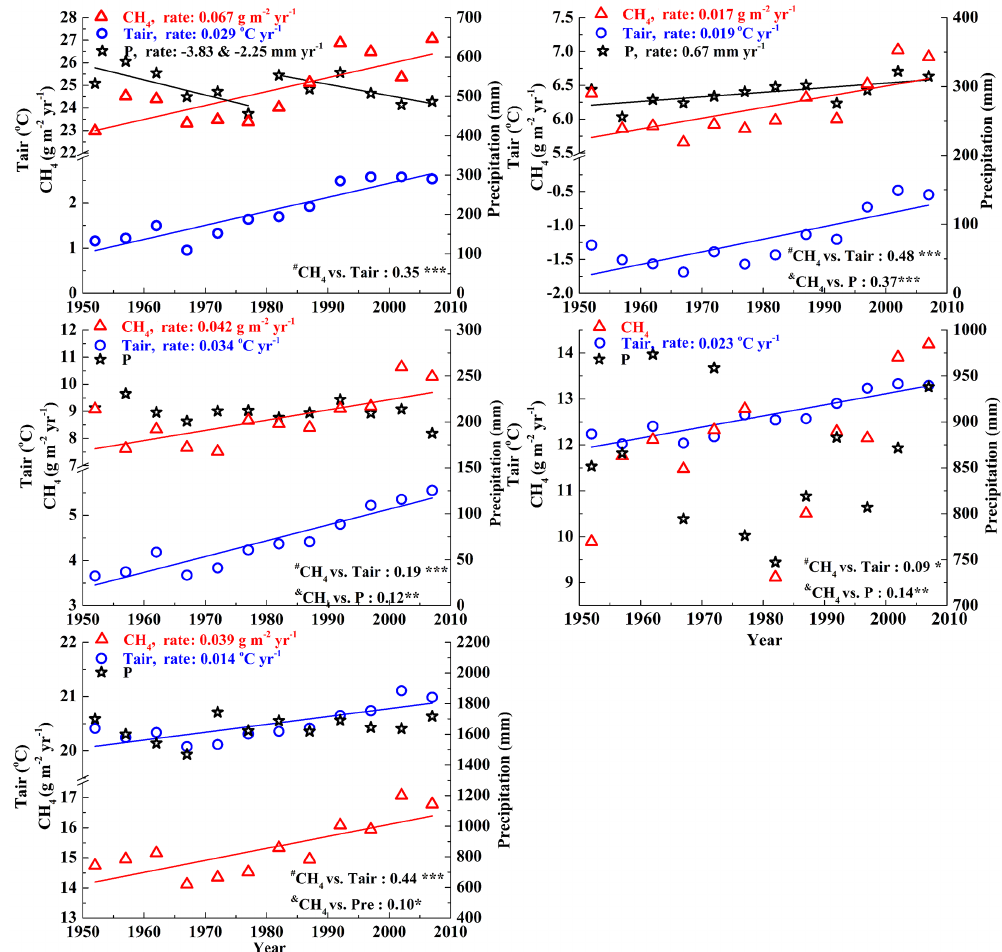
Figure 5. Impact of the climate factors on CH 4 fluxes from 1950 to 2010 in (a) Region I, (b) Region II, (c) Region III, (d) Region IV, and (e) Region V. The red triangles, blue circles, and the black stars are 5-year average CH 4 fluxes (the same data as in Fig. 4), air temperature, and precipitation, respectively. The slope represents the significant linear rate ( p <0.05). CH 4 vs. Tair: the correlation coefficient between the annual mean CH 4 fluxes and air temperature. CH 4 vs. P : the correlation coefficient between the annual mean CH 4 fluxes and the precipitation. Only correlations with statistical significance are shown ( p